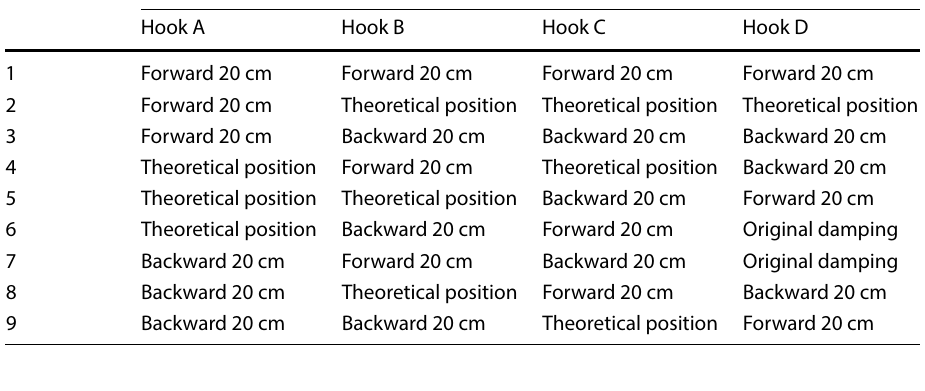
Table 1 Noise test scheme Test number The position change of four hooks in the exhaust system